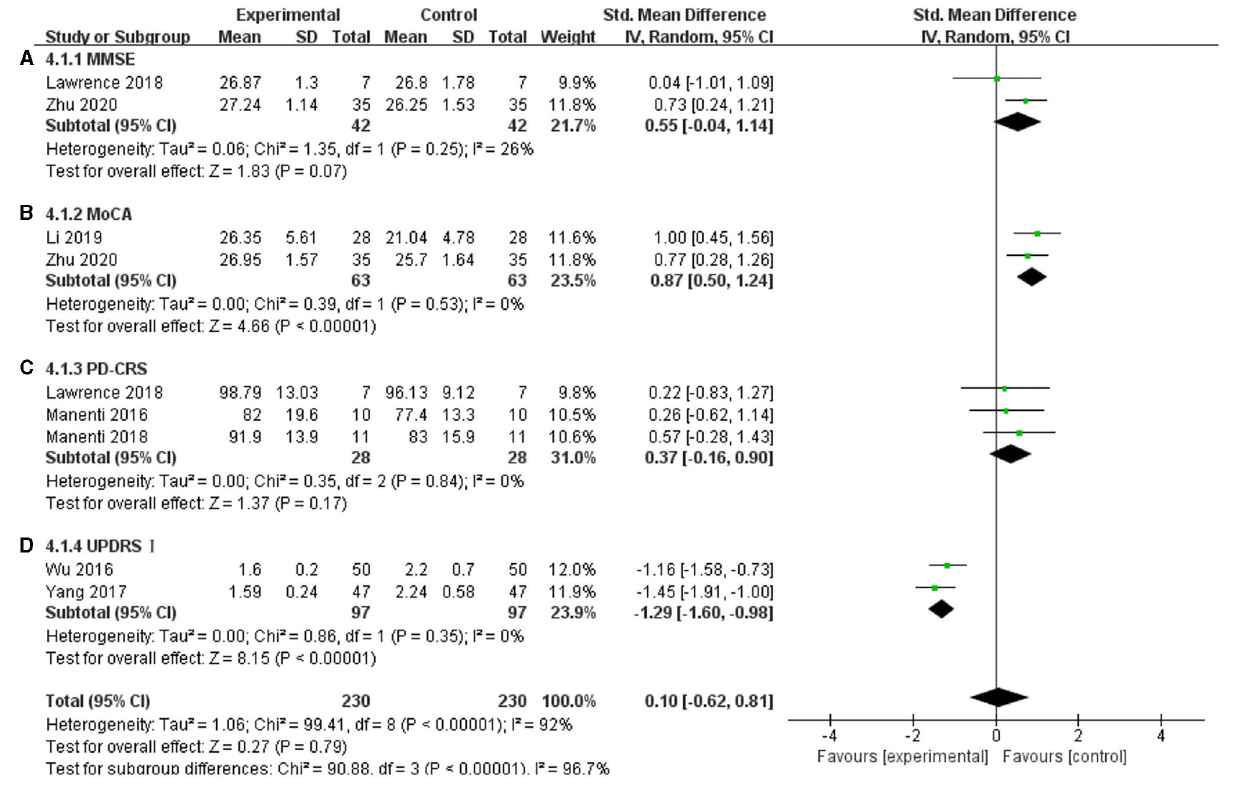
FIGURE 9 | Effects of tDCS on cognition and emotion in patients with PD. (A) For the MMSE, there was a non-significant pooled effect size ( p = 0.07). (B) For MoCA, two studies showed a significant pooled effect size ( p < 0.00001). (C) tDCS had a non-significant effect on PD-CRS in PD patients ( p = 0.17). (D) For UPDRS I, two studies showed a significant pooled effect size ( p < 0.00001). CI, confidence intervals; MMSE, Mini-Mental State Examination; PD, Parkinson’s disease; PD-CRS, Parkinson’s disease-cognitive rating scale; SD, standard deviation; UPDRS, Unified Parkinson’s disease rating